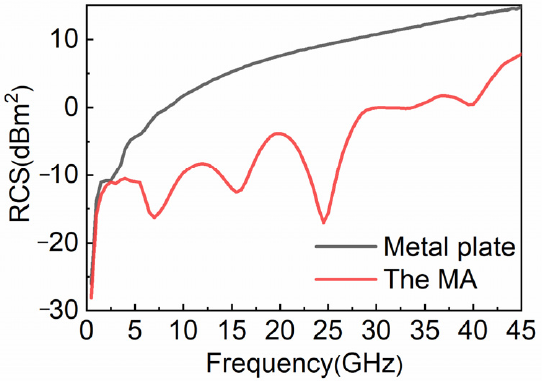
Figure 9. Radar cross-section of absorber and metal plate.